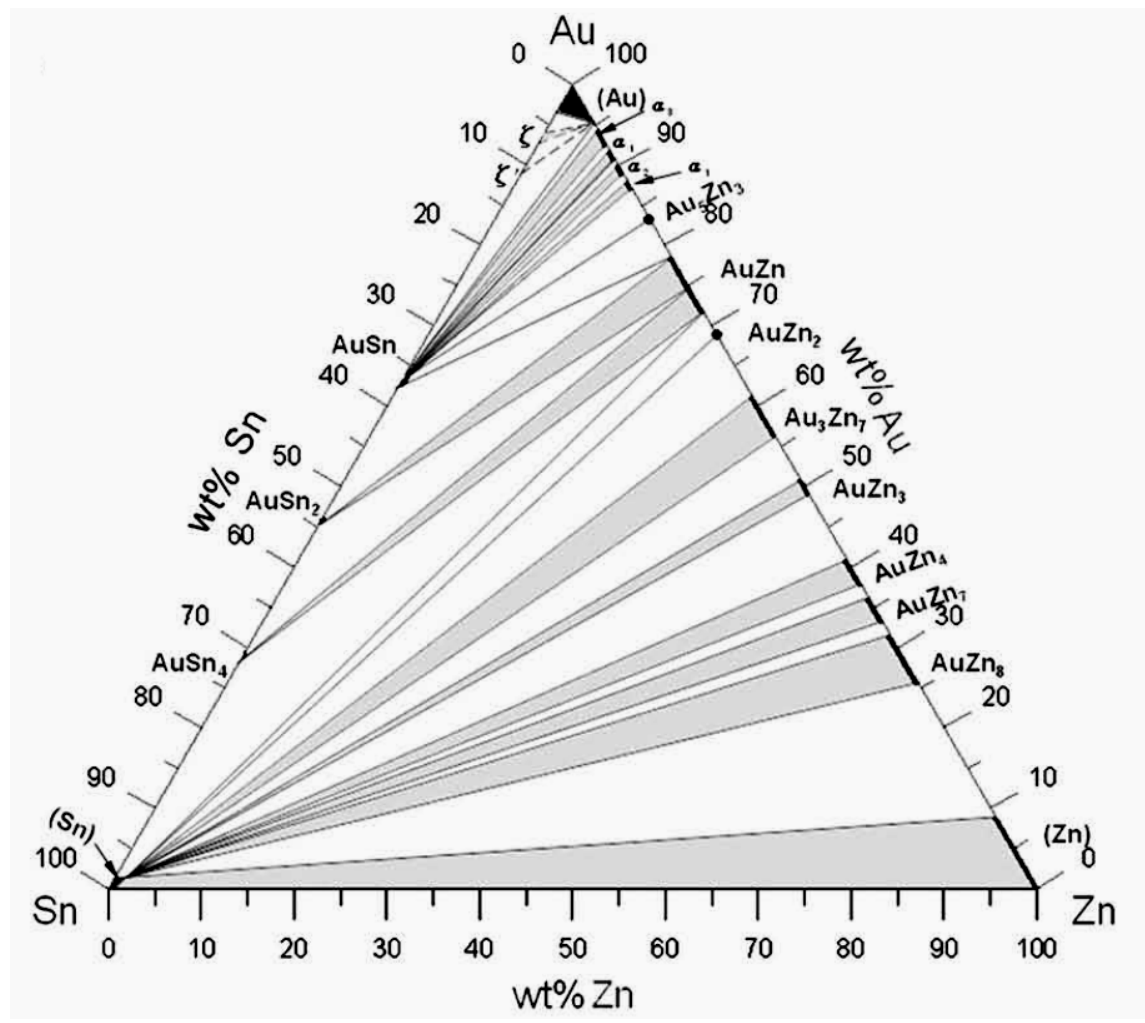
Figure 26. Isothermal section of the Au-Sn-Zn system at 175 °C